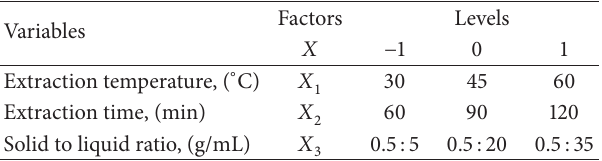
Table 1: Independent variables and their levels used for Box- Behnken